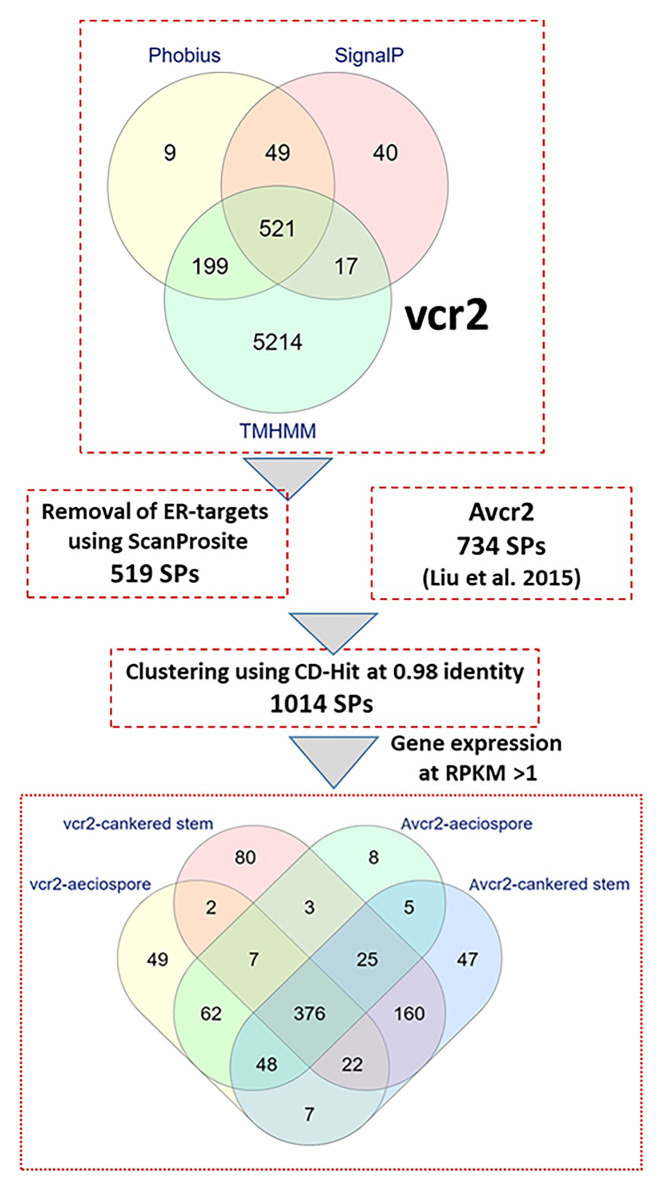
In-silico secretome prediction and identification of pathotype-specific effectors using a combination of computational programs. Putative full-length proteins were used to predict presence of signal peptides by using SignalP-v5.0 and Phobius. Proteins with transmembrane (TM) domains were removed by using TMHMM-v2.0 and Phobius. Proteins targeted to endoplasmic reticulum (ER) were removed by using ScanProsite. Cri secreted proteins from vcr2 and Avcr2 pathotypes were clustered by using CD-Hit. Within the Cri secretome, pathotype-specific effectors and those exclusively expressed in cankered host tissues were determined by mapping RNA-seq reads with a threshold of FPKM >1. The Venn diagram at bottom showing number of unique and shared proteins identified in Cri vcr2 and Avcr2 secretomes.